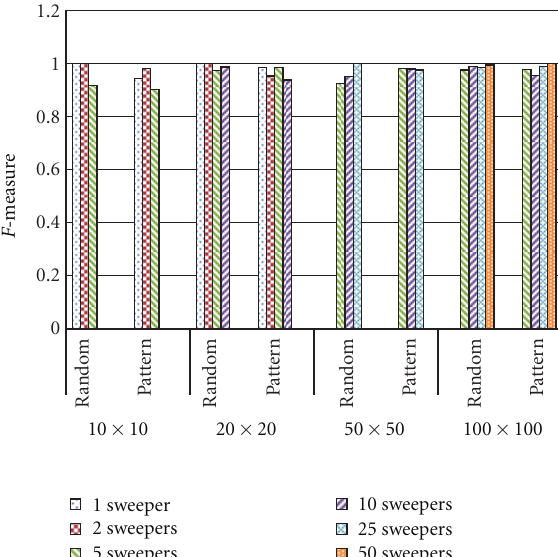
Figure 10: F -measure in random versus pattern-based distribution